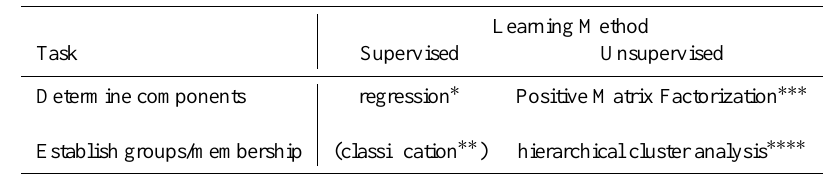
Table 1. Statistical learning methods – both supervised (known components or groups) and unsupervised (unknown components or groups) – used for analysis of FTIR